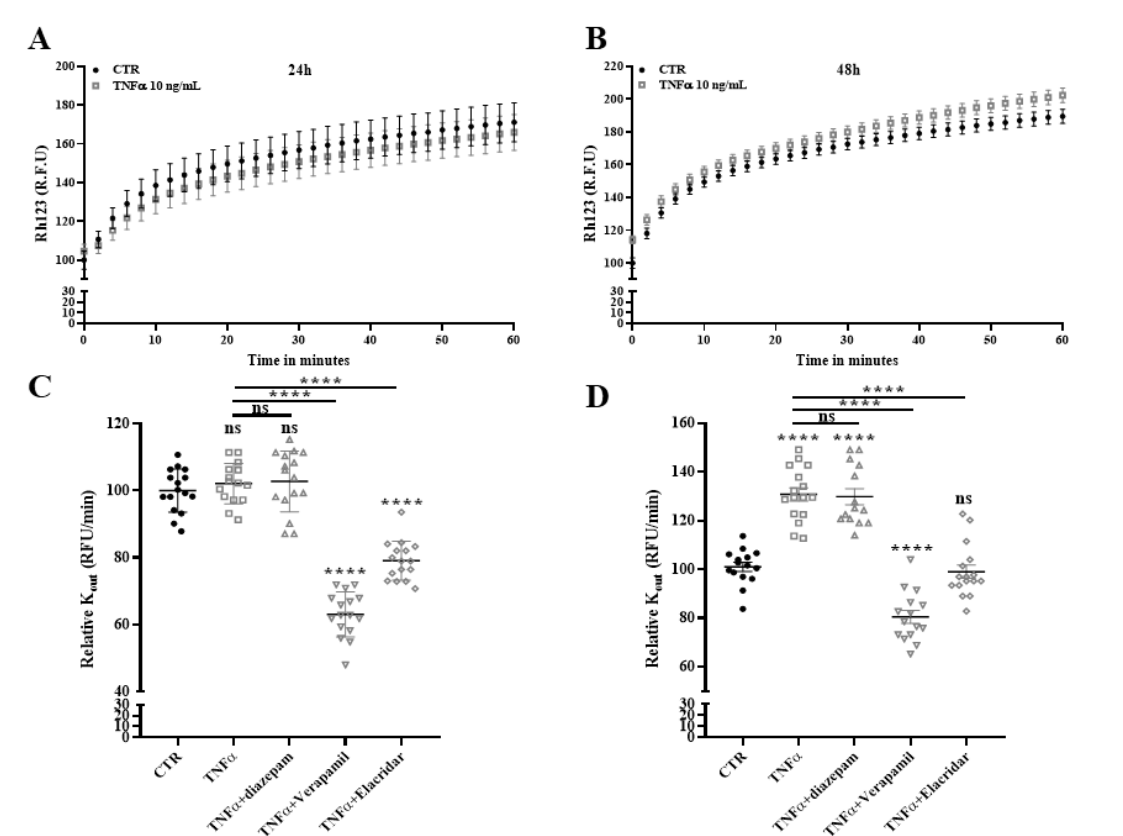
Figure 9. TNFα increases ABCB1 function in HBP. Rhodamine 123 (Rh 123) is an ABCB1 substrate and its efflux is monitored in real time during 1 h in TNFα -treated HBP for 24 h ( A ) and 48 h ( B ). Efflux rate (K out ) of rhodamine 123 was measured in the absence or presence of ABCB1 inhibitors and calculated as described in the Materials and Methods section ( C , D ). K out for control (CTR) condition was fixed at 100% and relative K out of each condition was calculated (CTR 24 h: 42.36 RFU/min ± 0.92; CTR 48 h: 43.95 RFU/min ± 2.22). Each bar represents the mean ± SEM of two independent experiments within eight replicates each (N = 2; n = 16). Statistical analysis: one-way ANOVA followed by Tukey’s multiple comparison: ns: non -significant, **** p < 0.0001.